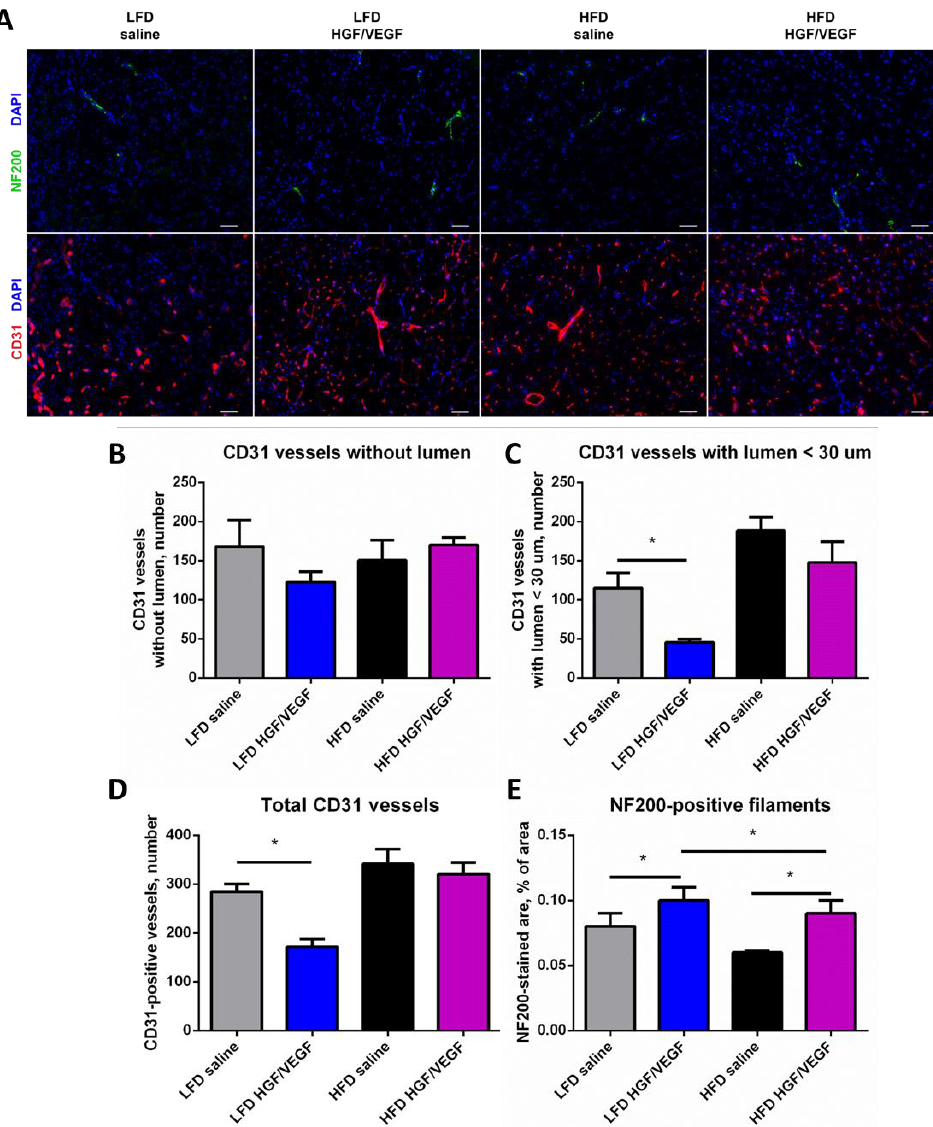
Figure 5. HGF/VEGF plasmid injection demonstrated limited impact on angiogenesis and activated both arteriogenesis and neuritogenesis under LFD conditions while under HFD was limited to neuritogenesis. (10 + 3 weeks of experiment). ( A )representative images panel of NF200 and CD31 staining in m.tibialis anterior , scale bar 50 um; ( B – D )graphical presentation of blood vessel density analysis with average group values per field of view: CD31+ vessels without lumen ( B ), CD31+ vessels with lumen < 30 um ( C ), CD31+ vessels with lumen >30 um ( D ); ( E ) graphical presentation of neurites density analysis with average group values per field of view. Data is presented as mean ± SEM; Kruskal –Wallis test with post hoc Dunn’s test; * p < 0.05.